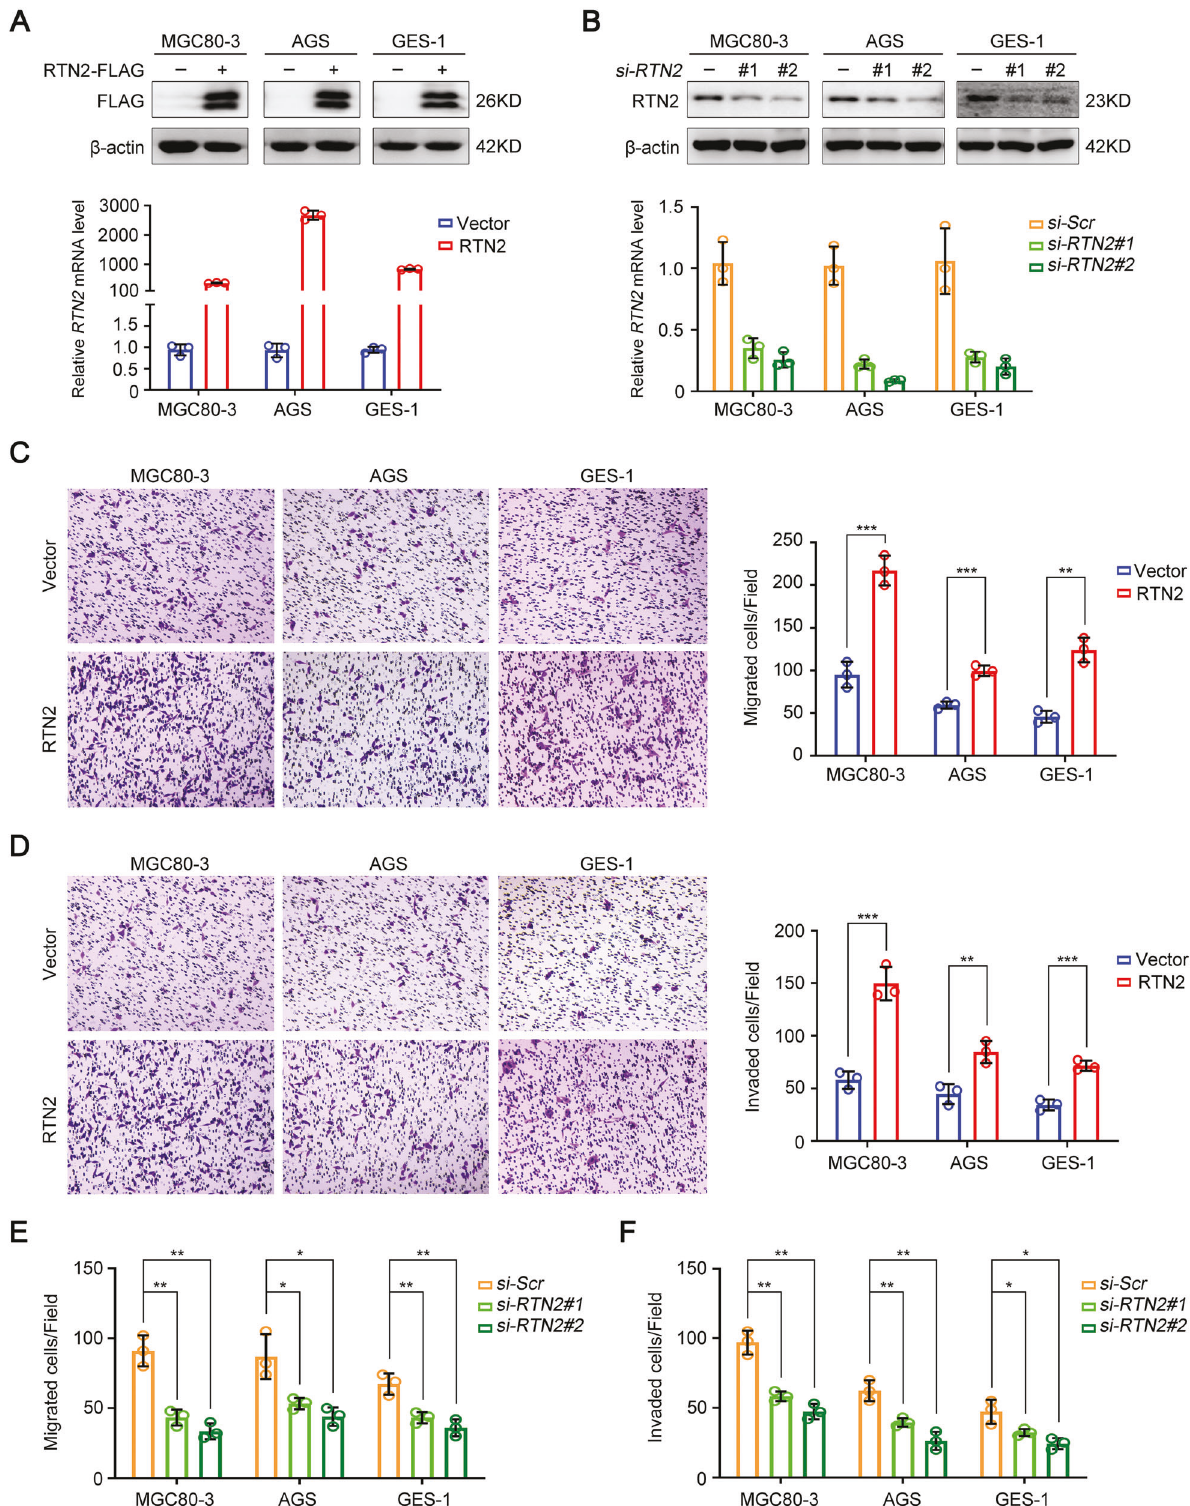
Fig. 3 RTN2 promotes migration and invasion of gastric cancer cells in vitro. A , B The overexpression ( A ) and knockdown ( B ) ef fi ciencies of RTN2 in MGC80-3, AGS and GES-1 cells were monitored by western blot (upper panel) and real-time PCR (lower panel), respectively. C – F Transwell assays were employed to determine the in fl uence of RTN2 on the migratory and invasive abilities in MGC80-3, AGS and GES-1 cells. C , D The effects of RTN2 overexpression on the migratory ( C ) and invasive ( D ) abilities in MGC80-3, AGS and GES-1 cells. E , F The effects of RTN2 knockdown on the migratory ( E ) and invasive ( F ) abilities in MGC80-3, AGS and GES-1 cells. Data are represented as mean ± SD ( A – F ), and statistical signi fi cance was calculated by Student ’ s two-tailed t test ( C – F ). * P < 0.05; ** P < 0.01; *** P < 0.001.